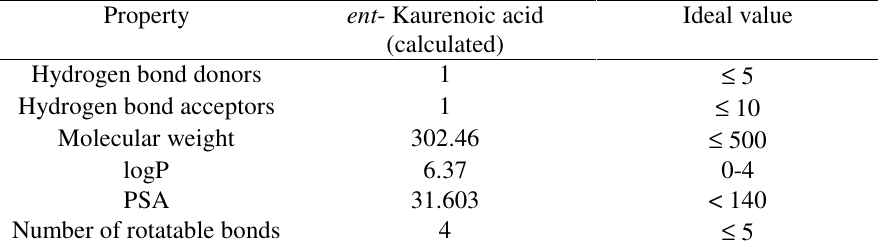
Table 1 . Tabulated Properties of ent -Kaurenoic